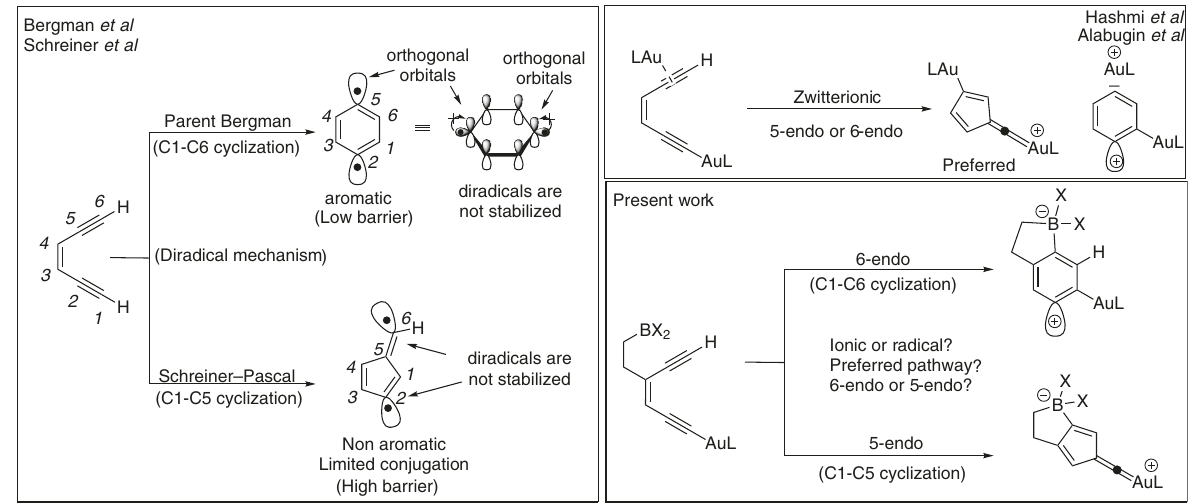
Fig. 2 Possible outcomes in the cyclization of enediynes. The left box shows the conventional C 1 – C 6 Bergman ( BC ) and C 1 – C 5 Schreiner – Pascal ( SP ) cyclizations giving diradicals. The top right depicts the dual Au(I)-catalyzed zwitterionic version of BC , and the bottom right box shows the present work on the boron-Au(I) triggered zwitterionic BC and SP cyclizations.